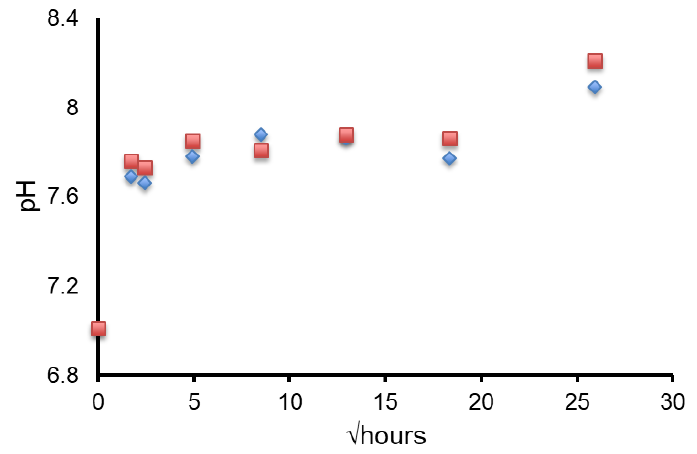
Figure 8. pH changes for Na-FBAG ( (cid:7) ) and K-FBAG ( (cid:4) ) after immersion in AS7 for up to 4 weeks. Errors smaller than data points.